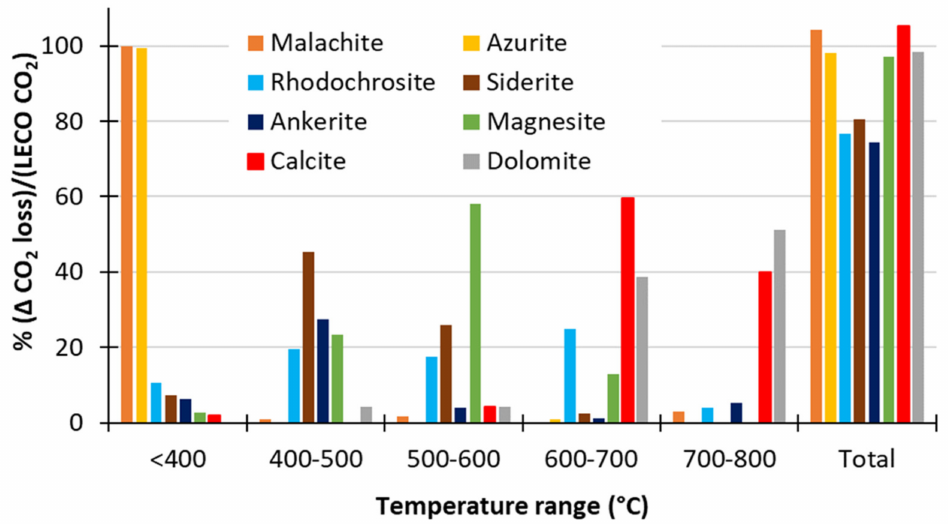
Figure 1. Percentage (%) of expected CO 2 emission as a function of temperature range using O 2 as the carrier gas. ∆ CO 2 emission is, for instance, the CO 2 emission measured at 500 measured at 400 ◦ C. The data are normalised by the LECO total carbon measurement to assess whether the decomposition is